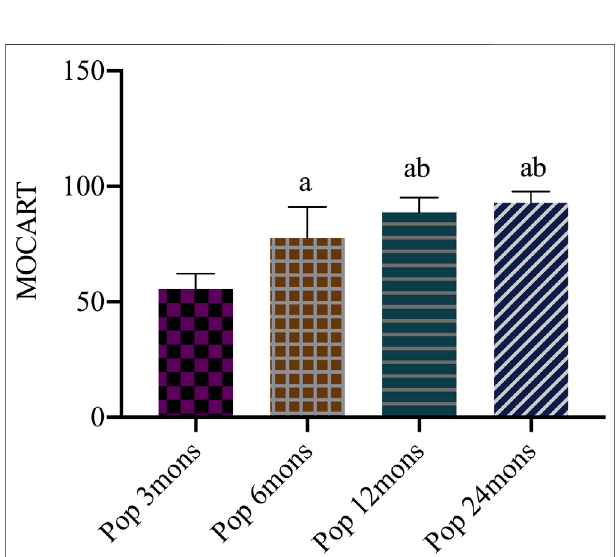
FIGURE 4 | Magnetic resonance observation of cartilage repair tissue (MOCART) score after operation. Pop, postoperation; mons, months; a, p < 0.05 (vs. pop three mons); b, p < 0.05 (vs. pop six mons); c, p < 0.05 (vs. pop 12 mons).